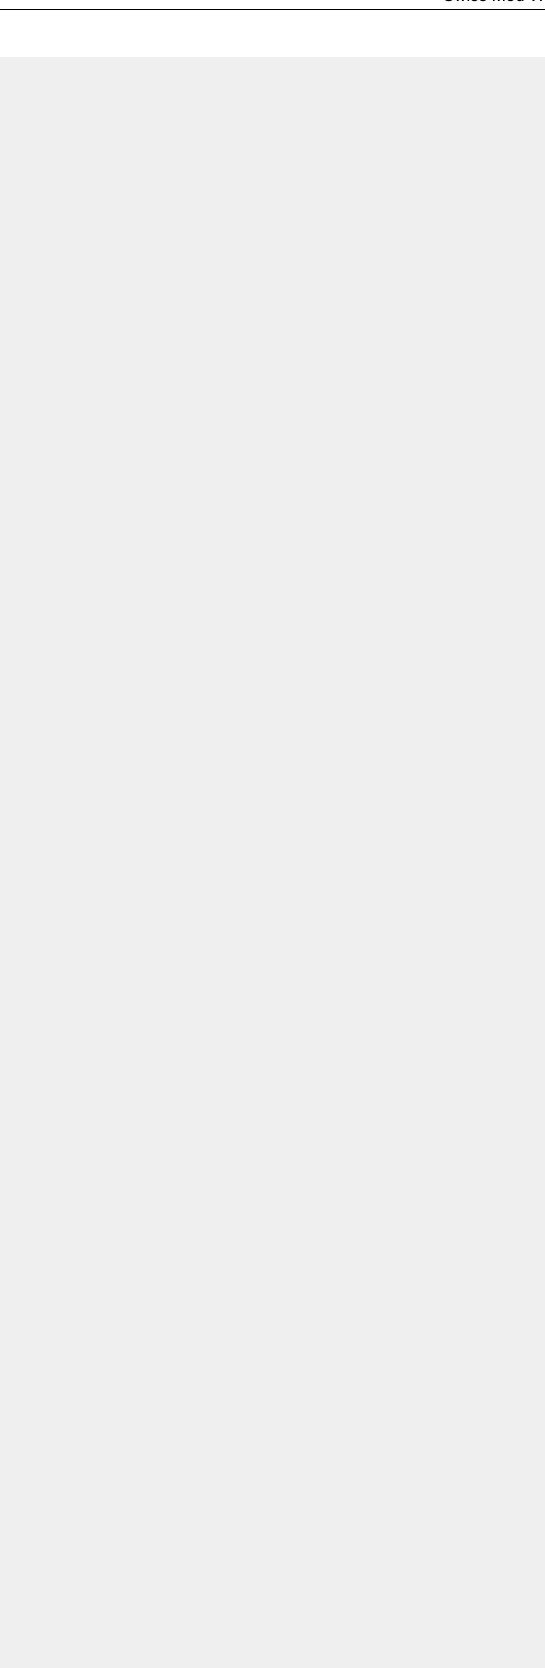
Figure 3 Chronic thromboembolic pulmonary hypertension (CTEPH). Segmental occlusions of pulmonary arteries (arrow) in the pulmonary angiography ( A ) are clearly visible on the CT angiography ( B ), with normal lung ( C ), and responsible for triangular perfusion defects (arrows) on the perfusion maps ( D ) confirmed by the ventilation-perfusion scintigraphy ( E–F